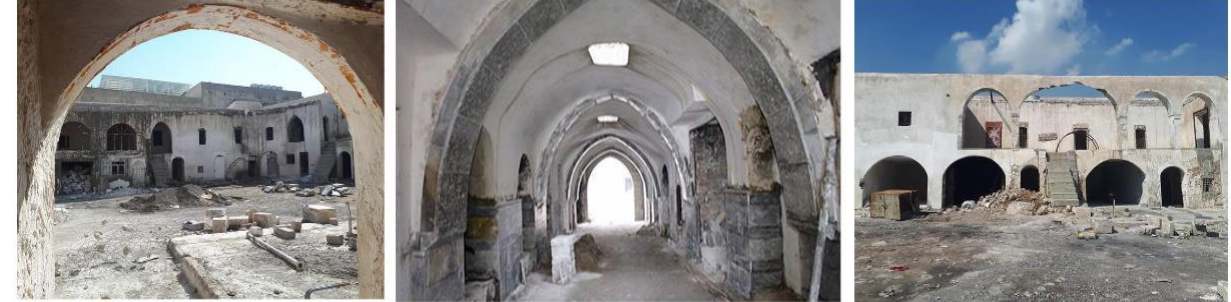
Figure 13. The effects of neglect and destruction of Khan Al-KummarK during the military operations reproduced with permeation from [https://www.uomosul.edu.iq/news/en/archeology/69515], (accessed on 27 April 2022) [30].